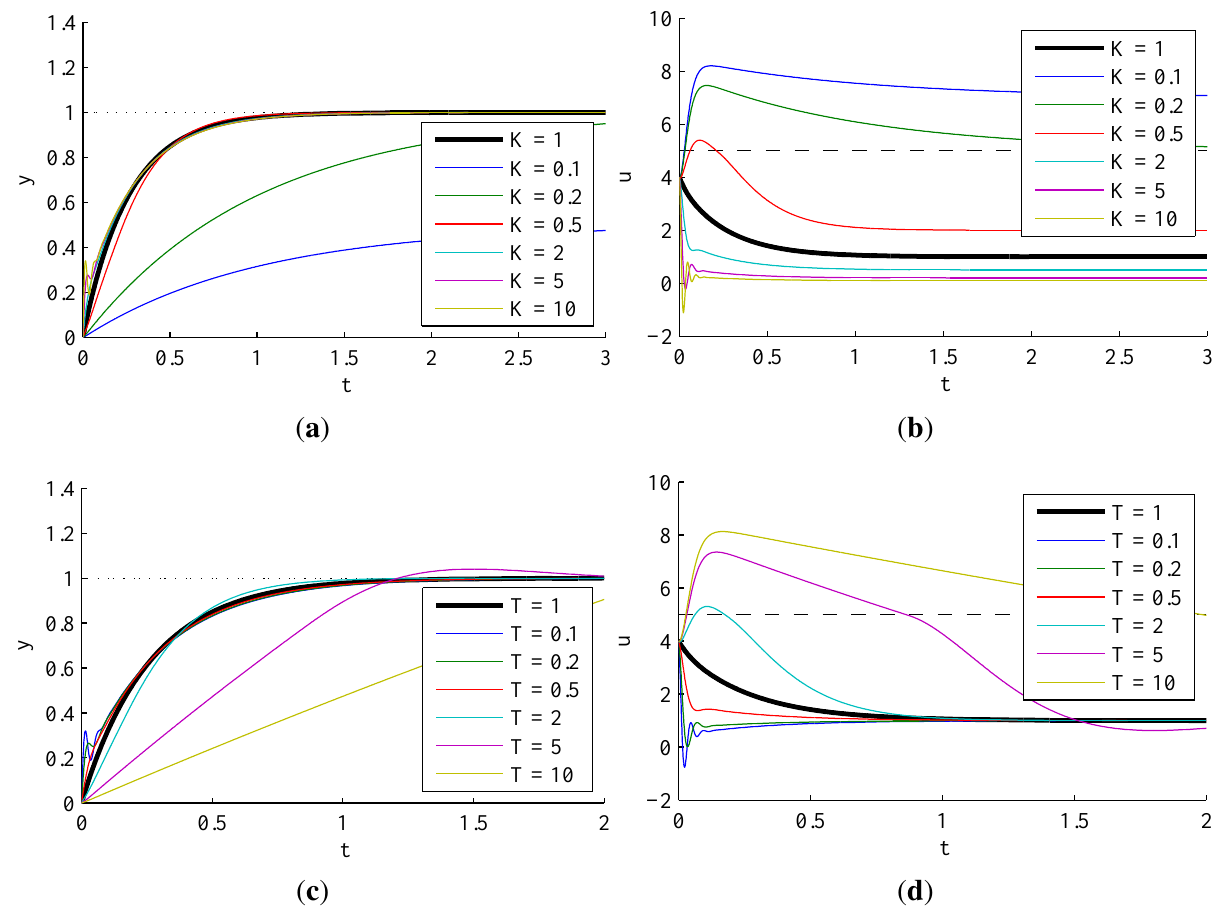
Figure 6. Experiment 3.1.3: effect of actuator saturation, ADRC controlling first-order process with varying parameters. Nominal process parameters: K = 1, T = 1. ADRC parameters: b side, the controller outputs are shown before the limitation (dashed line) takes effect. ( a ) Variation of K , closed loop step response; ( b ) Controller output u for ( a ); ( c ) Variation of T